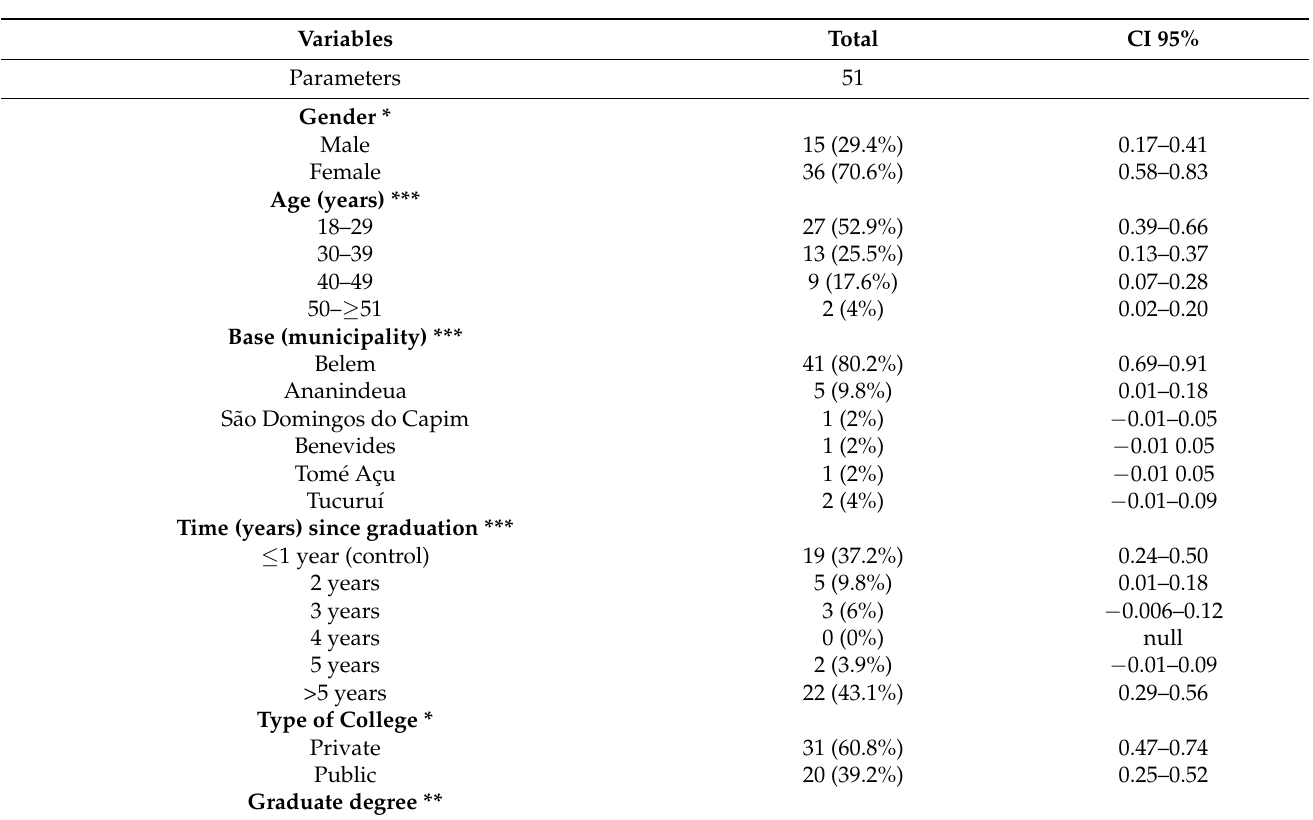
Table 1. Socioeconomic profile and risk behavior related to HIV infection among people with